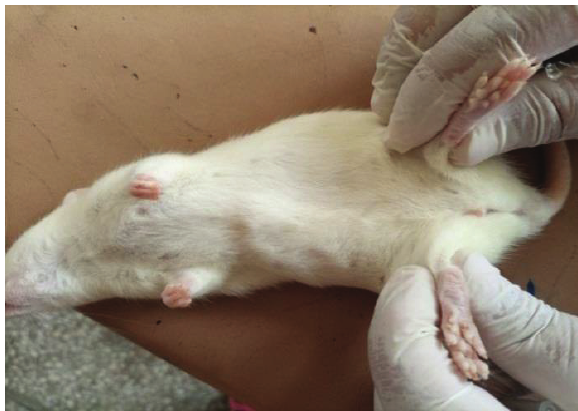
Fig-1: Rat of Group B with hind paws showing edema and redness